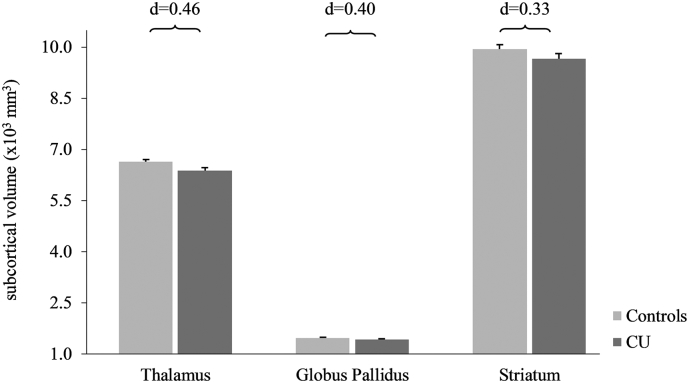
Subcortical measures at baseline.Subcortical mean volume measures (×103 in mm3) and standard errors in cocaine users and controls. All values corrected for age, verbal IQ, ADHD-SR score, and ICV.None of the group differences survived multiple comparisons correction. Cohen's d controls vs. cocaine users.